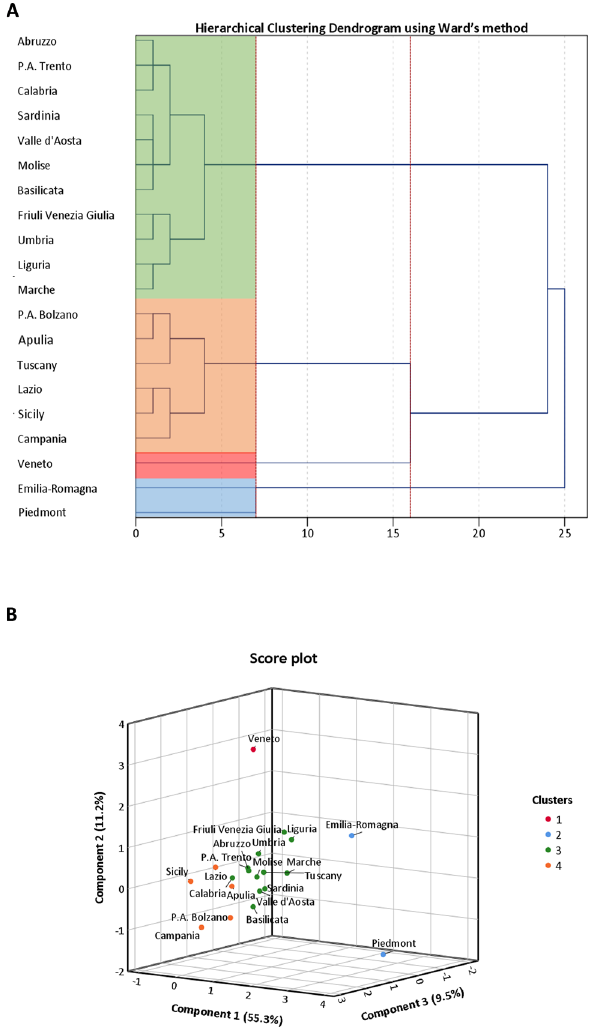
Figure 3. Clustering on Principal Components (PCs) after excluding Lombardy. ( A ) Dendrogram of Hierarchical Clustering based on the Ward’s criterion. The height of the branches indicates the dissimilarity between clusters. The dendrogram was partitioned (red dotted lines) to maximize the distance between nodes. Cluster solution is indicated by four colored panels. ( B ) Three-dimensional Score plot illustrating how clusters were distributed on PCs. The number of clusters to be retained was set according to the dendrogram and cluster solution was consolidated by K-means